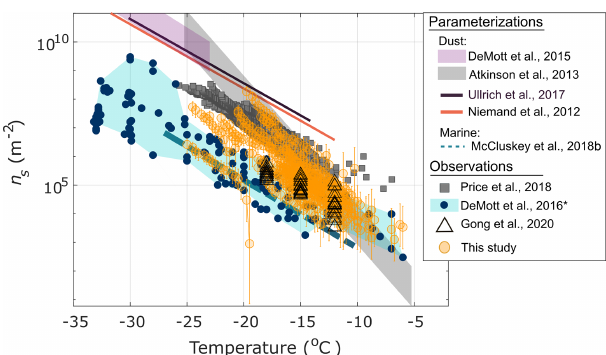
Figure 3. Ice-active surface site densities ( n s ) as a function of tem- perature for 25 of 26 aerosol samples collected during AQABA. Gong et al. (2020a) and Price et al. (2018a) measured INPs in dust- dominant air masses in the tropical East Atlantic, with minor con- tributions from SSA, while the DeMott et al. (2016) measurements were collected across a range of locations and conditions within the marine boundary layer comprising air masses mostly dominated by relatively pristine marine SSA (Gong et al., 2020b; Price et al., 2018b). INP concentrations measured in sample f033 were below the detection limits imposed by field blanks (see Sect. 2.4, Fig. S7). Error bars represent 95% binomial sampling confidence intervals (Agresti and Coull, 1998). Sample f020 is not shown due to miss- ing aerosol surface area data during the sampling period. For the eight samples on which a dilution was performed (Fig. S8), n s for both the raw undiluted and diluted samples are shown. ∗ DeMott et al. (2016) data shown have been updated with additional data from Yang et al.